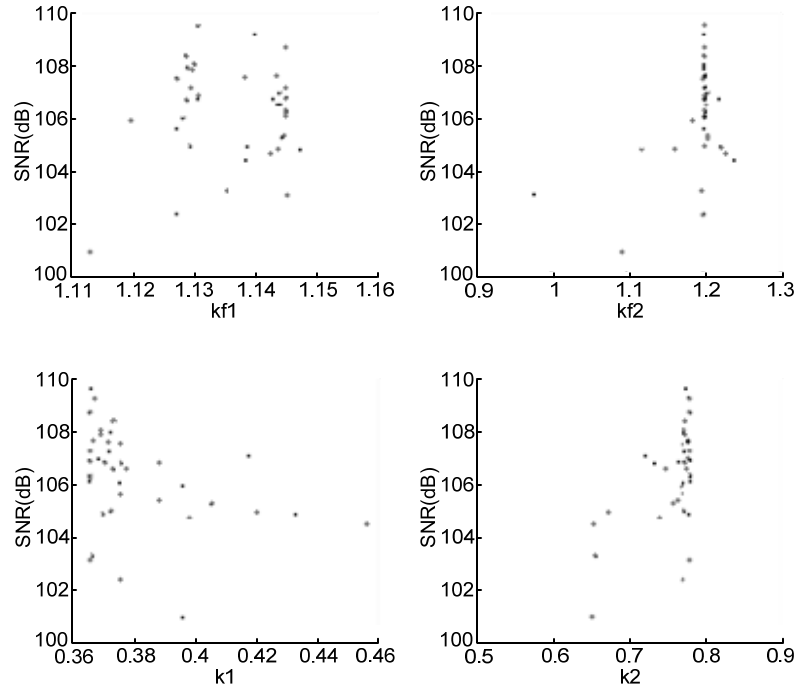
Figure 5. Scatter plot for the EM ΣΔ M gain constants (k1–k2 and kf1–kf2) of the 40 individuals remaining after thinning and